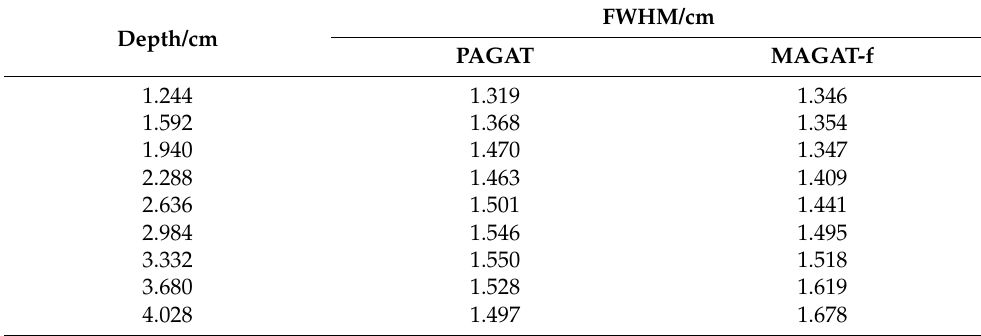
Table 6. FWHW at different depths measured with PAGAT and MAGAT-f for 73.5 MeV beam. Depth/cm